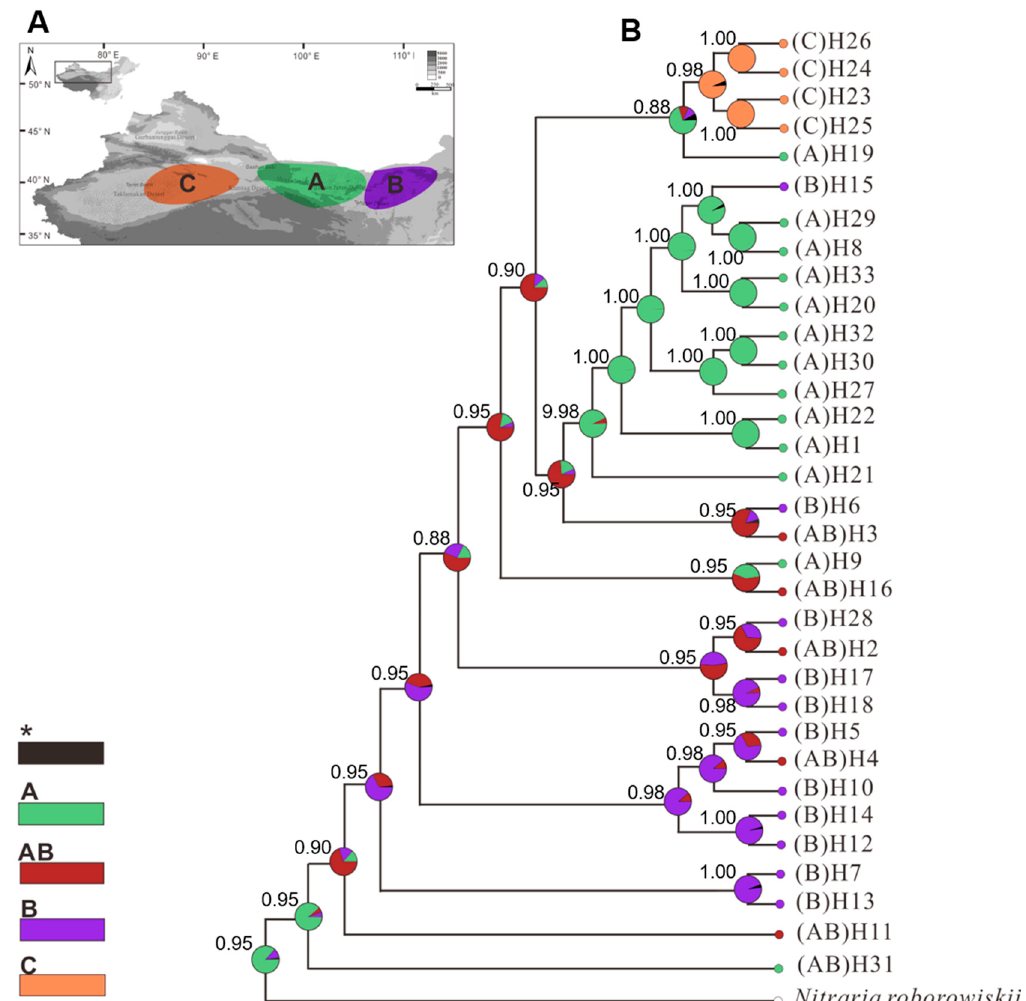
Figure 3. Reconstruction of the ancestral distribution of Nitraria tangutorum based on chloroplast DNA (cpDNA) haplotypes as determined by reconstruct ancestral state in phylogenies (RASP) analysis. ( A ) Different colors represent different origin groups as shown in the map insert. ( B ) Results of the Bayesian Binary Markov chain Monte Carlo (MCMC) analysis. The pie chart in each node indicates the possible ancestral distribution inferred from Bayesian Binary MCMC (BBM) analysis implemented in RASP. The number above the branches indicate bootstrap support values above 80. H1-H33 represent 33 haplotypes. A, East-A group; B, East-B group; C, West group; AB, East group.